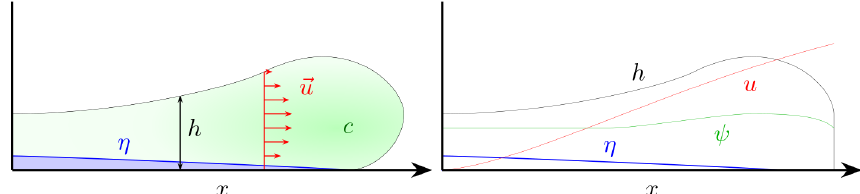
Figure 1. This schematic representation of a dense gravity current (left) and a corresponding depth-averaged shallow water approximation (right) shows current height h , volume fraction c , depth-averaged volume fraction ψ , velocity u , the forward component of the depth-averaged velocity u , and deposit depth η